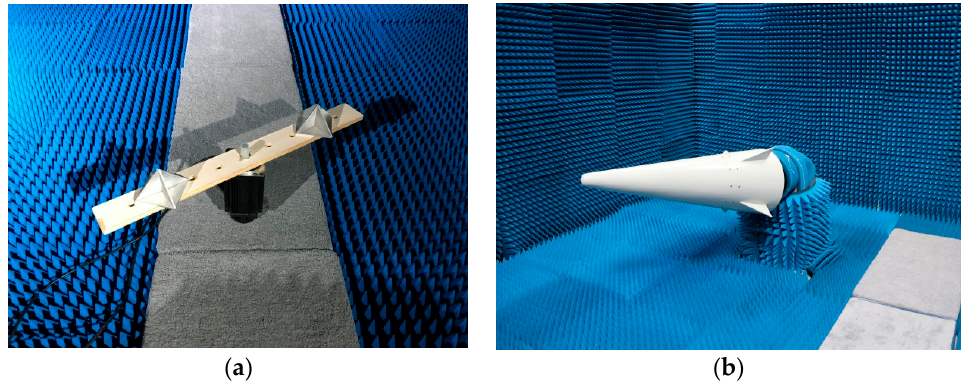
Figure 4. The micro-motion targets in experiments. ( a ) The rotating corner reflectors. ( b ) The precession warhead model.